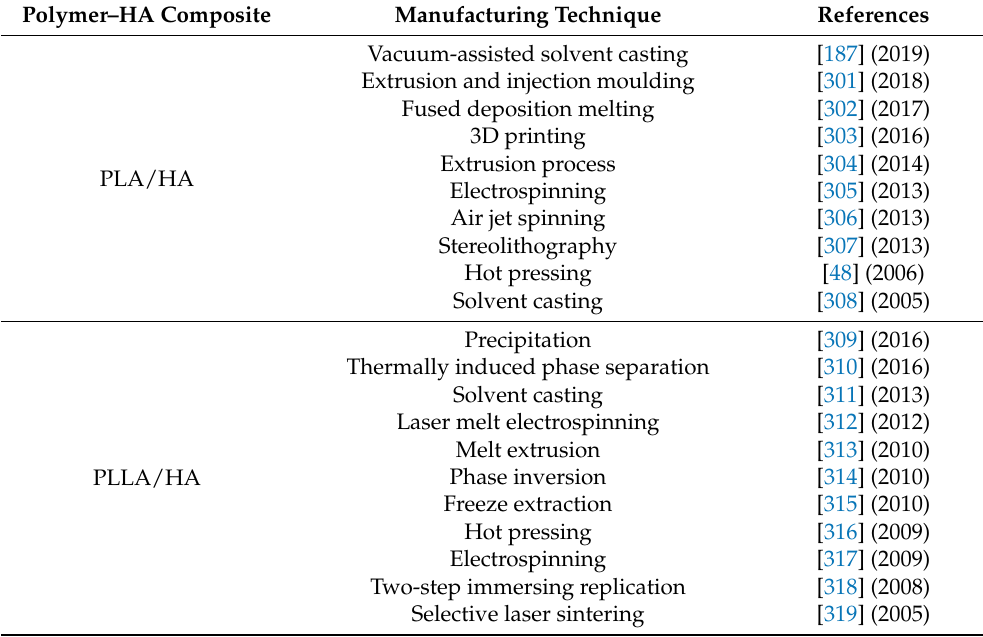
Table 4. Techniques for producing polymer – HA composites for use in transitional dental im- plants.